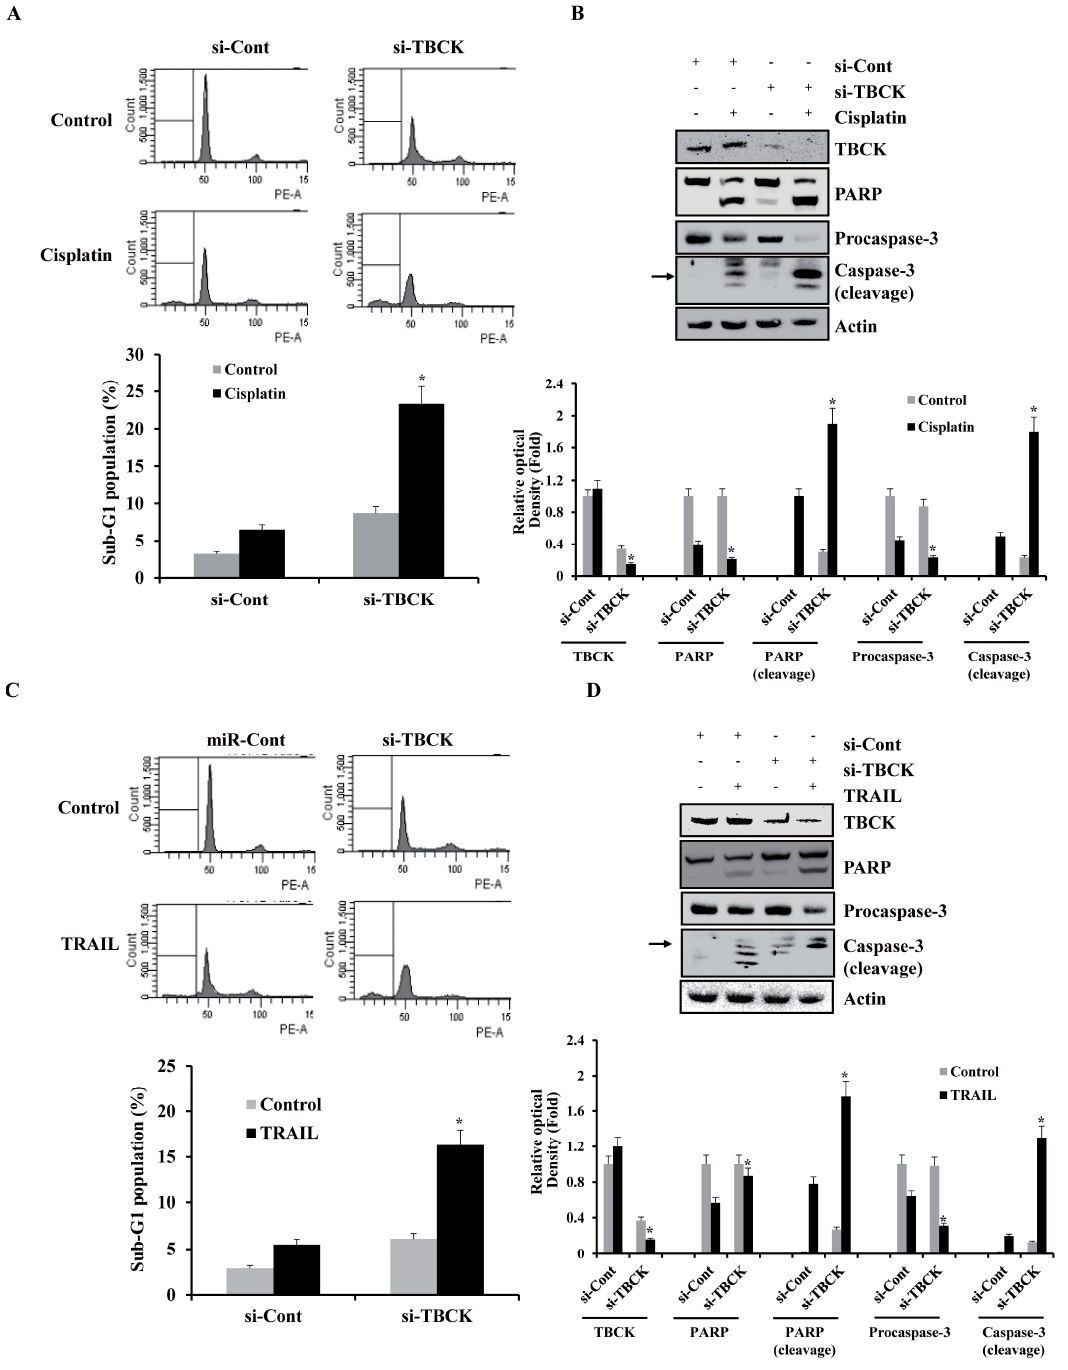
Figure 7. si-TBCK-mediated TBCK downregulation increases the sensitivities to cisplatin or TRAIL. ( A ) Caki-1 cells were transfected with si-Cont or si-TBCK. After 24 h transfection, the cells were treated with cisplatin for 24 h. FACS analysis was performed to measure a sub-G1 fraction. Histograms of flow cytometry are shown in the upper panel . Percentages of sub G1 populations are